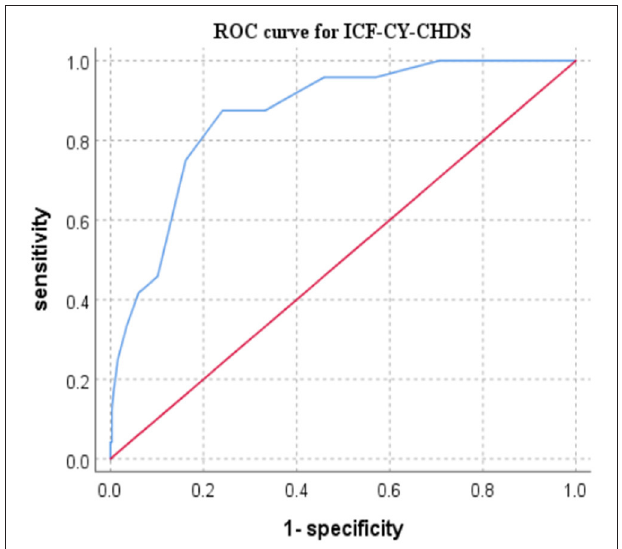
FIGURE 4 | Receiver operating characteristic (ROC) curve of the